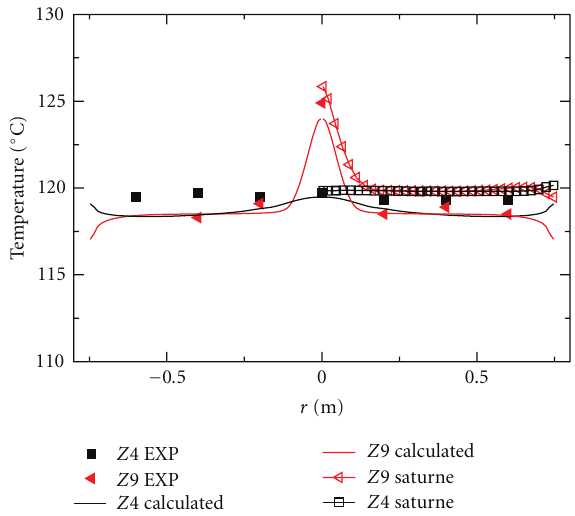
Figure 10: Radial profile of the gas temperature at Z 4 = 1 . 47 m and Z 9 = 2 . 675 m: steady state